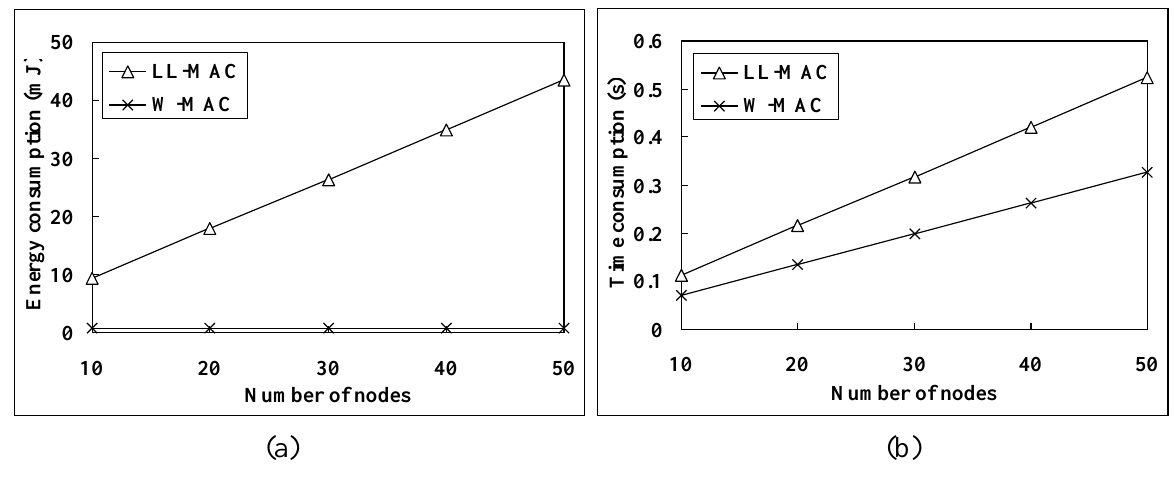
Figure 10. Analysis and simulation result of P 